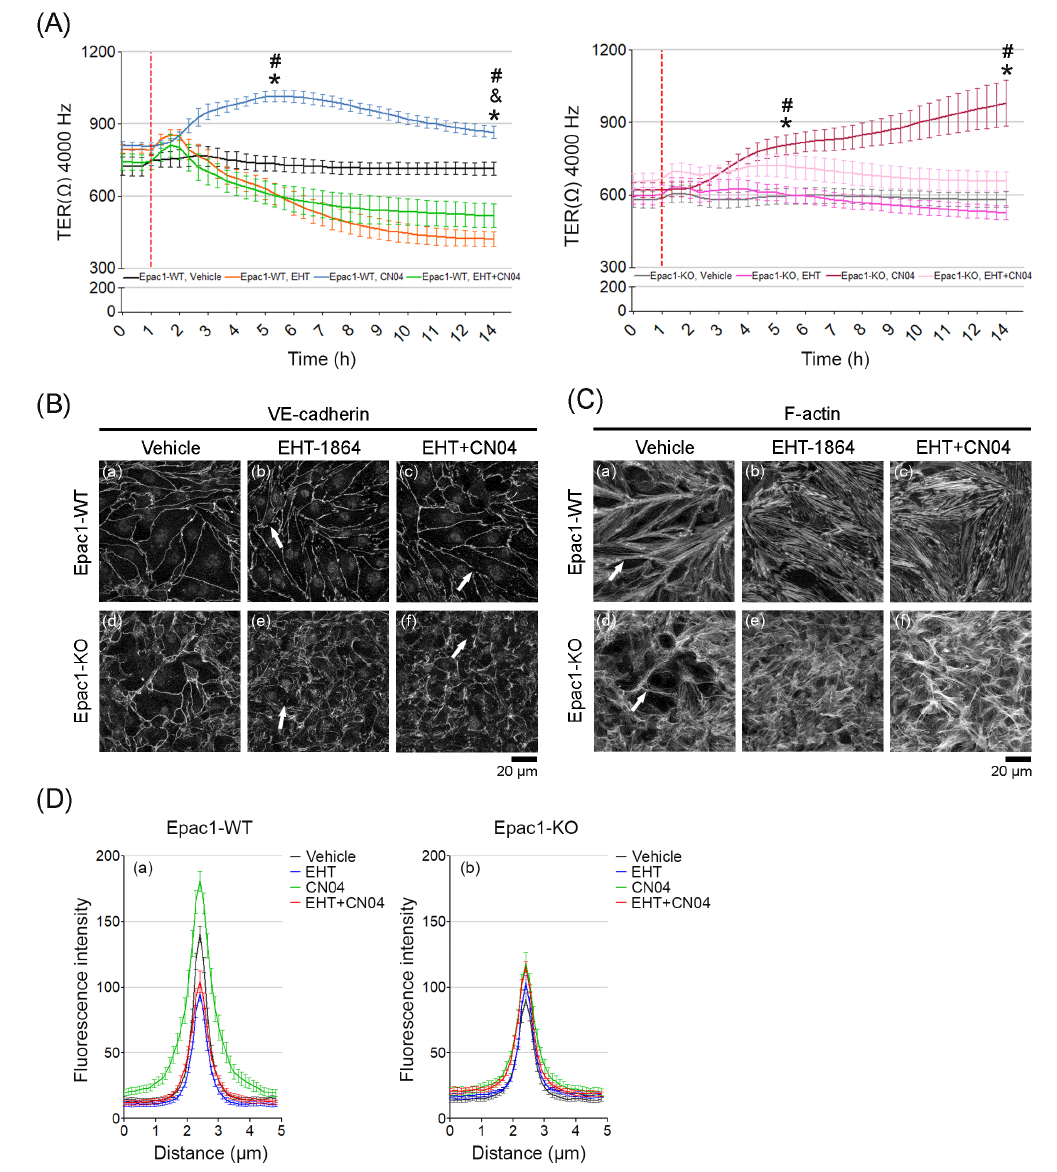
Figure 7. E ff ects of Rac1 inhibition with EHT-1864 on TER, VE-cadherin, and F-actin. ( A ) Shows the barrier resistance (TER) of confluent WT or Epac1-KO endothelial cell monolayers during 14 h of incubation. After 1 h (segmented red line), the cells received either vehicle (H2O), EHT-1864, or CN04 alone, and EHT-1864 + CN04; N = 5; n = 10 for each condition, “*” shows significance for vehicle vs. the respective CN04 groups; “&” for vehicle vs. EHT-1864; “#” for CN04 vs. EHT-1864. ( B ) Shows VE-cadherin immunostaining of confluent WT and KO cell monolayers; N = 3 for each condition, given either vehicle (a and d), EHT-1864 (b and e), or EHT-1864 + CN04 (c and f). The arrows indicate the sites with disrupted VE-cadherin staining. ( C ) F-actin stained confluent cell sheets treated similar to panel B; N = 3. ( D ) The intensity of VE-cadherin staining from panel B was quantified by densitometric measurements, (a) for WT and (b) for the Epac1-KO cells; N = 3; n = 25 cells per